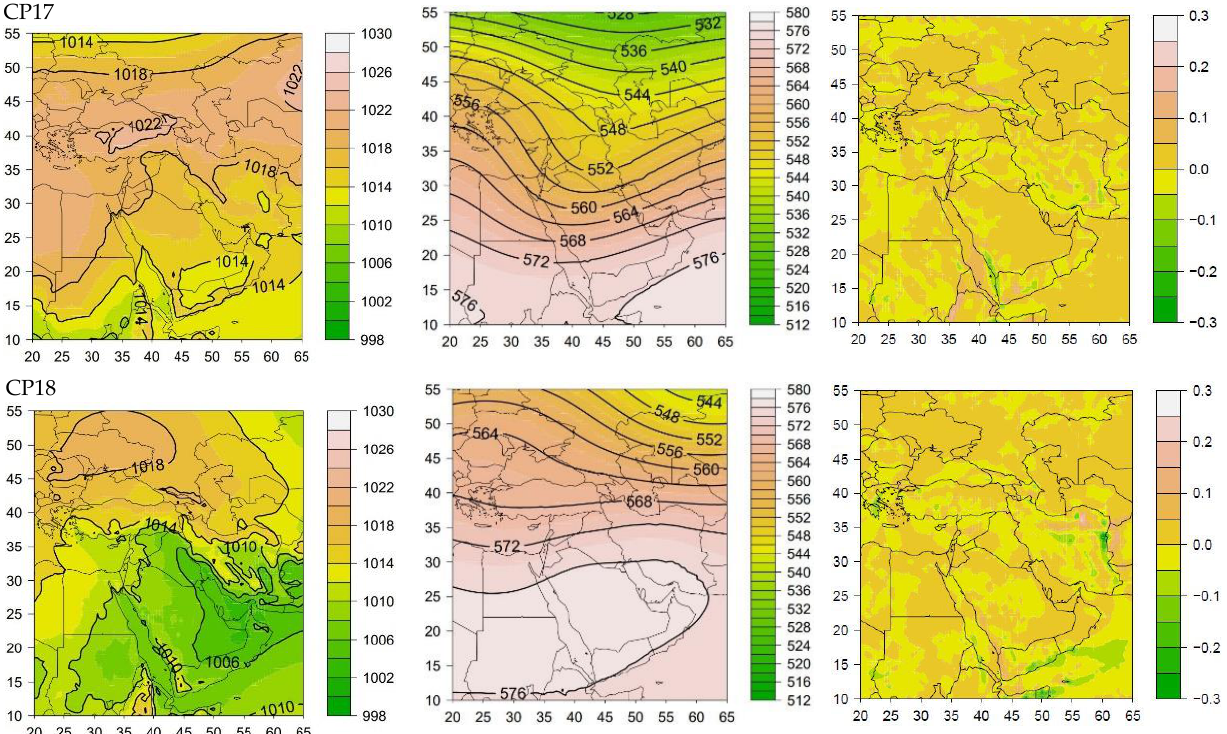
Figure 6. As in Figure 2, for patterns 17 – 18.